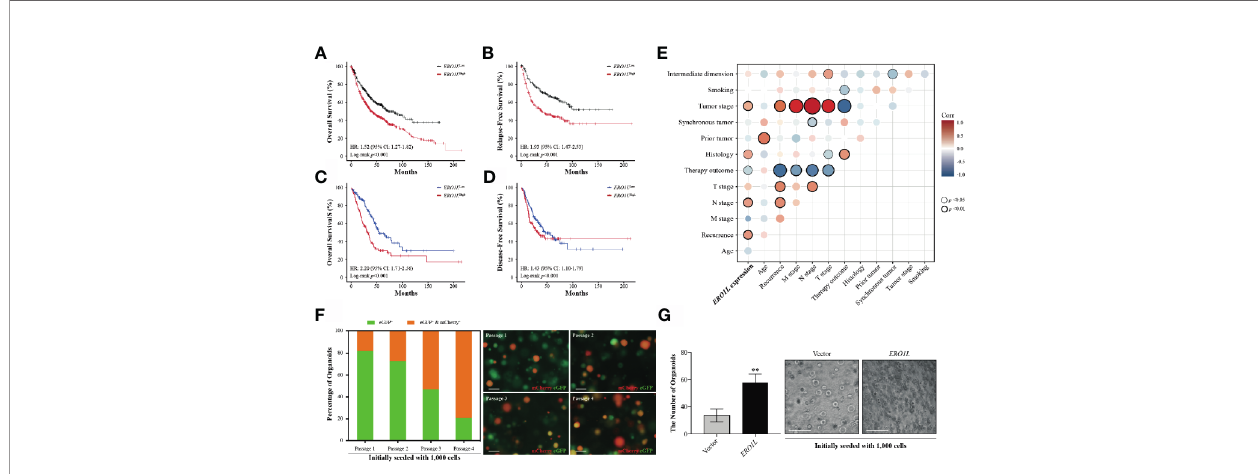
FIGURE 2 | Overexpression of ERO1L predicts a poorer prognosis in LUAD. (A, B) Survival analysis comparing low and high expression levels of ERO1L in the Kaplan-Meier plotter database. Overexpression of ERO1L was correlated with signi fi cantly poorer overall survival (A) and relapse-free survival (B) . Overexpression of ERO1L was correlated with signi fi cantly poorer overall survival (C) and disease-free survival (D) . (E) Association between the expression of ERO1L and clinicopathological characteristics in patients with LUAD. (F) Fluorescence images of ERO1L -overexpressed organoids show an increase in the number of chimeric organoids over passaging. (G) Quanti fi cation of ERO1L upregulated organoids relative to the average number of organoid spheres in four random fi elds. ** p <